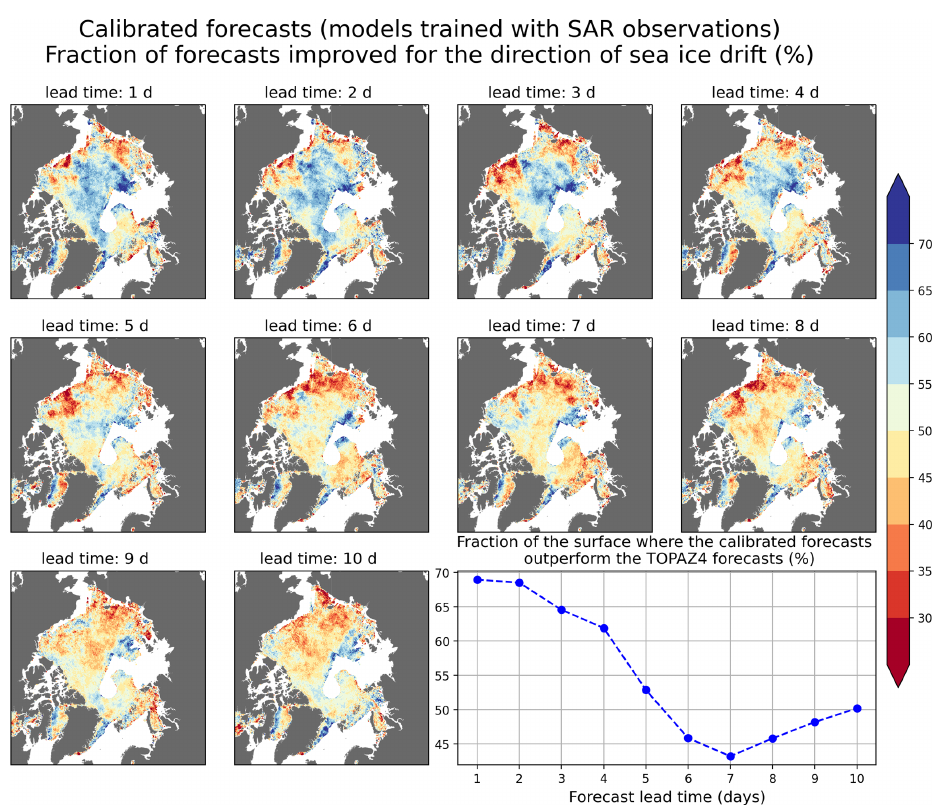
Figure 5. Fraction of calibrated forecasts produced by the models trained with SAR observations which outperform the TOPAZ4 forecasts for the direction of sea ice drift during the period from June 2020 to May 2021. Daily SAR observations have been used as reference. The graph in the lower right corner shows the fraction of the surface where the fraction of calibrated forecasts outperforming the TOPAZ4 forecasts is higher than or equal to